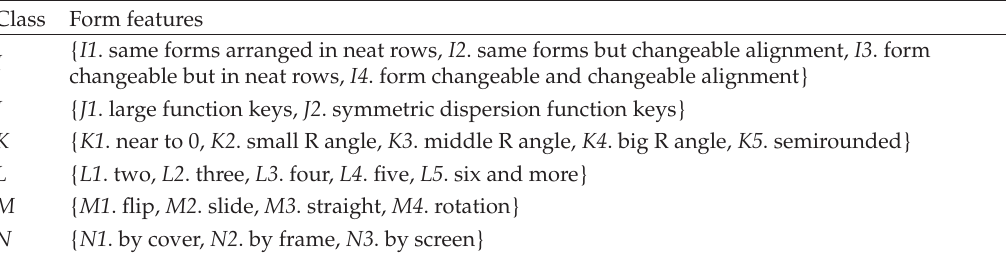
Table 3: Geometric connections and feature